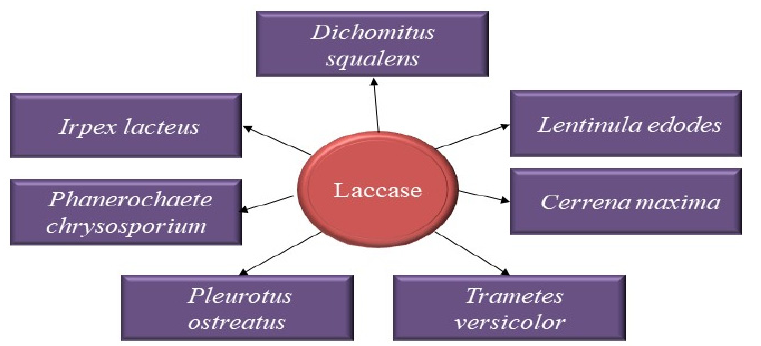
Figure 12. Key fungal groups actively producing Laccase enzyme which predominates the lignolytic enzyme group.